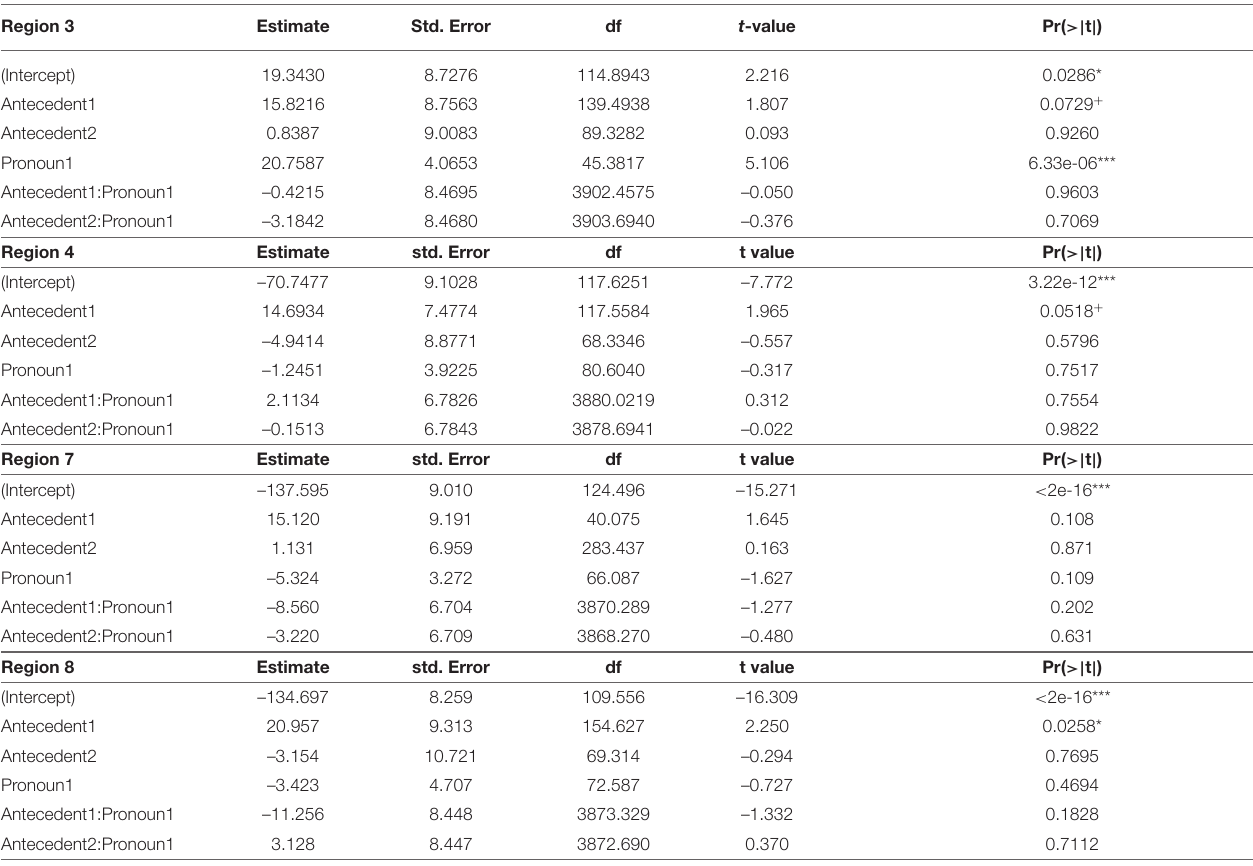
TABLE 5 | Fixed effects, Experiment 3, Regions 3, 4, 7, and 8. Region